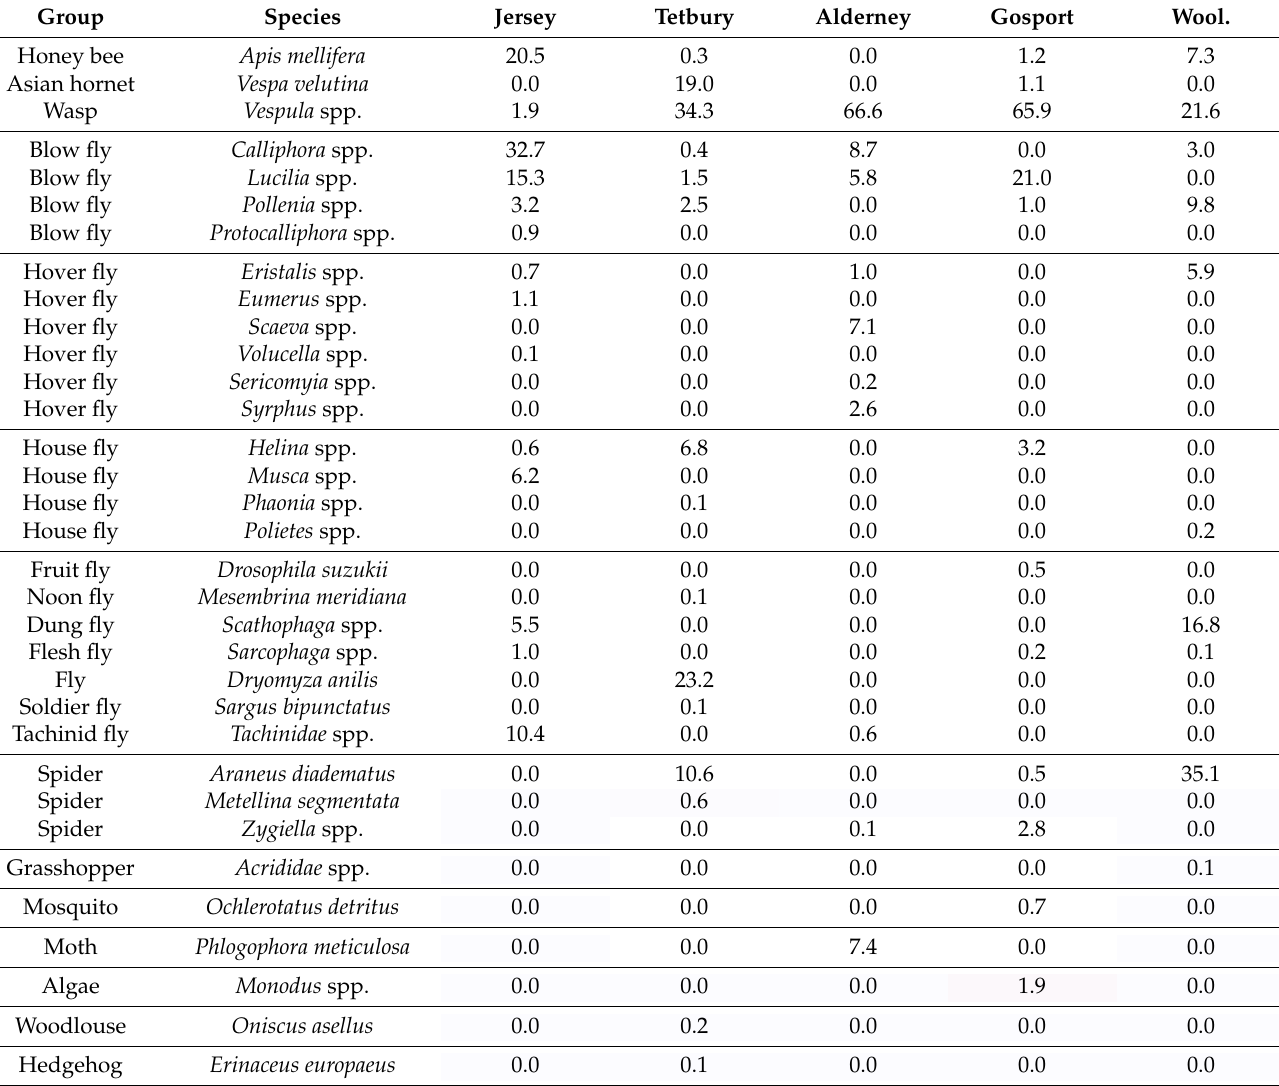
Table 2. List of common taxa found for each nest analysed and the relative percentage of sequencing reads assigned to each taxon for that